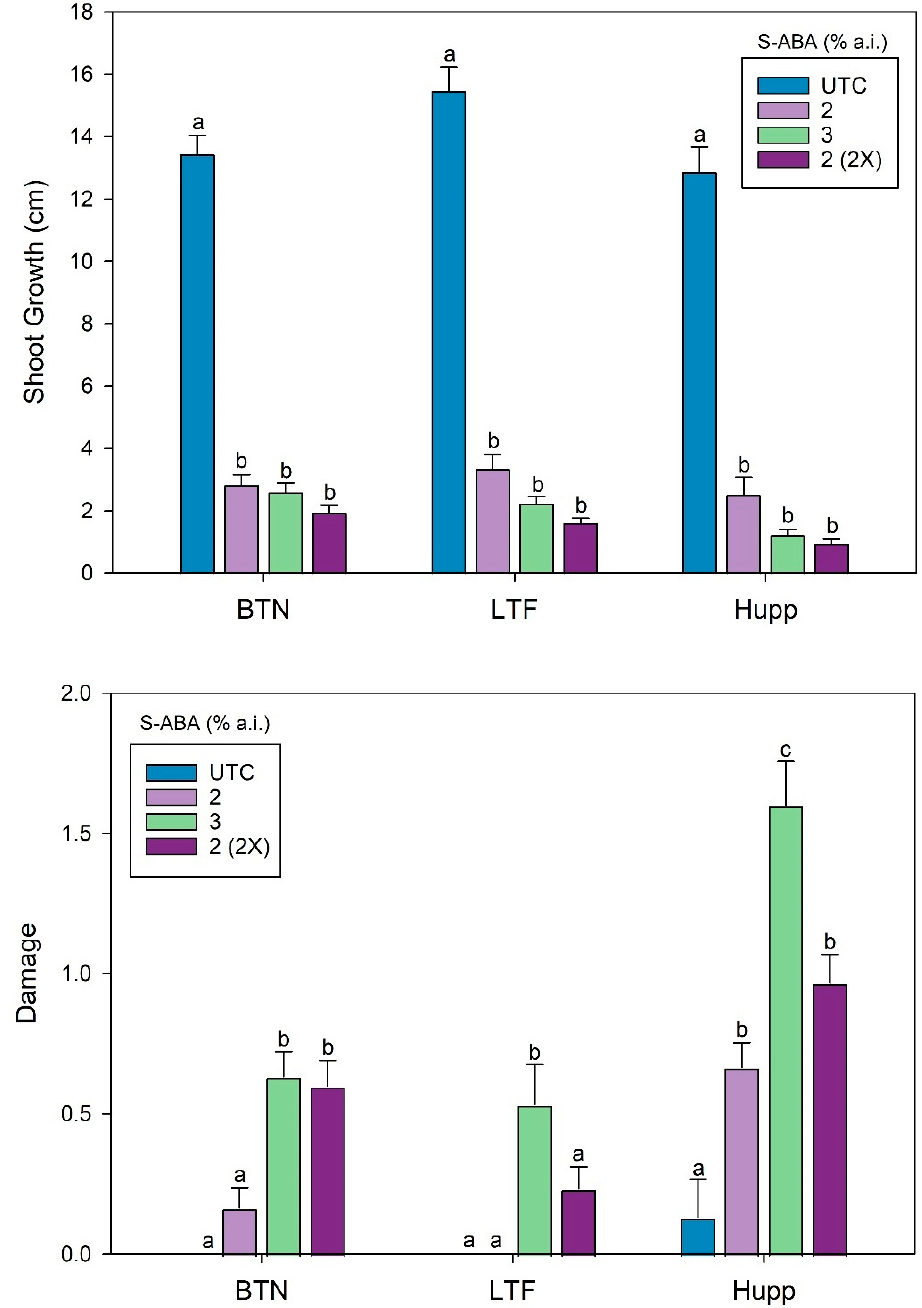
Figure 7. Mean shoot growth ( top ) and damage rating ( bottom ) of leaders of Turkish fir trees at three farms treated in 2020 with S-ABA applied once or as a repeated application (2 × ). S-ABA concentration is in % a.i. NOTE: Error bars indicate standard error of the mean. Means within a farm indicated by the same letter are not different at p = 0.05. Mean separation by Tukey’s HSD test. Damage rating (0 = no phytotoxicity; 4 = severe phytotoxic damage).